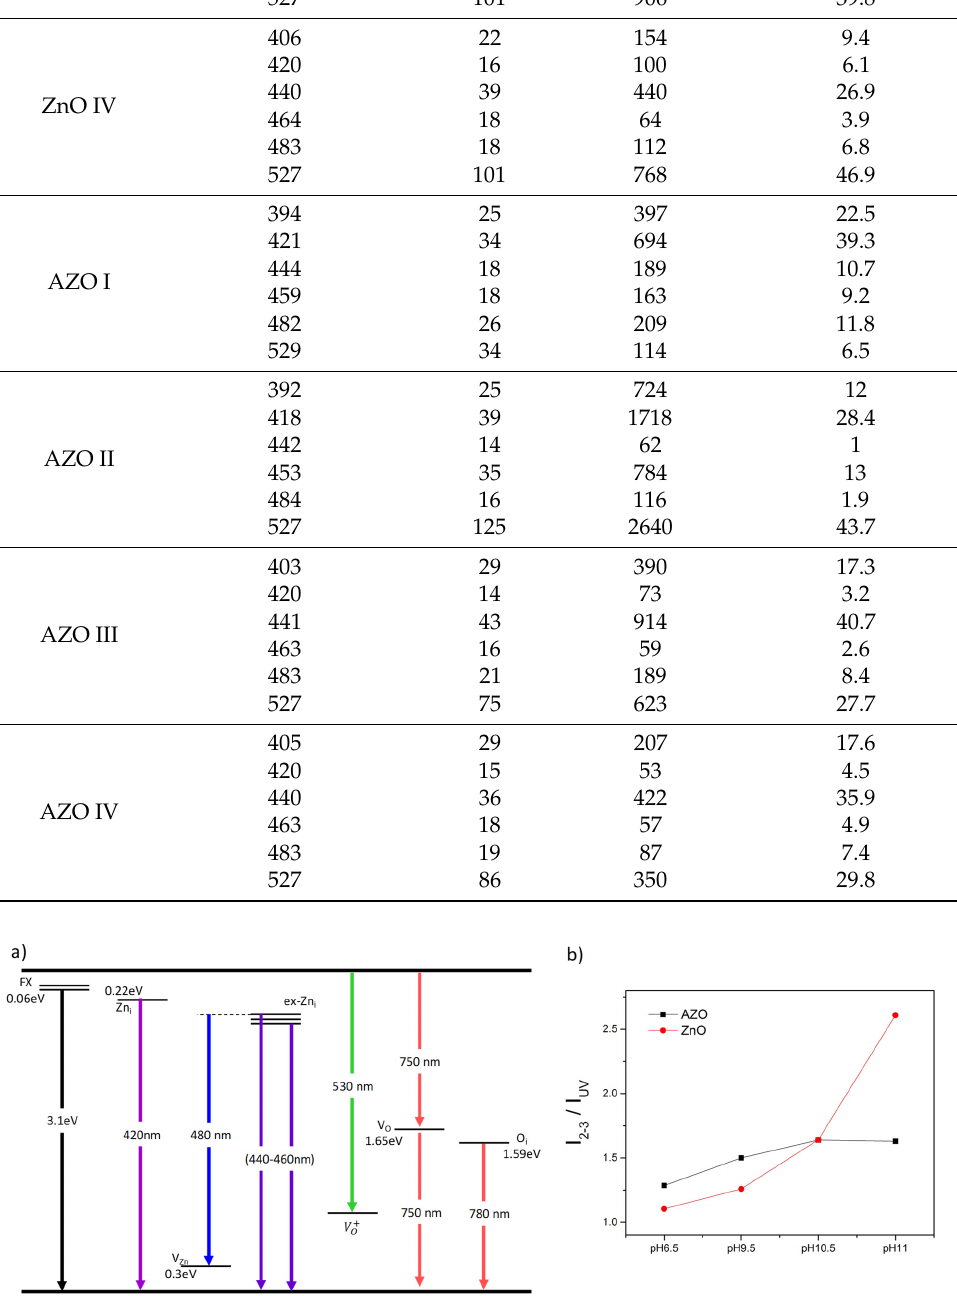
Figure 10. ( a ) Schematic diagram of the main PL radiative recombination centers, ( b ) the PL intensity ratio between the band-to-band emission I UV (~395 nm) and the violet I 2 (~420 nm) and blue-violet I 3 (~430 nm) emissions.